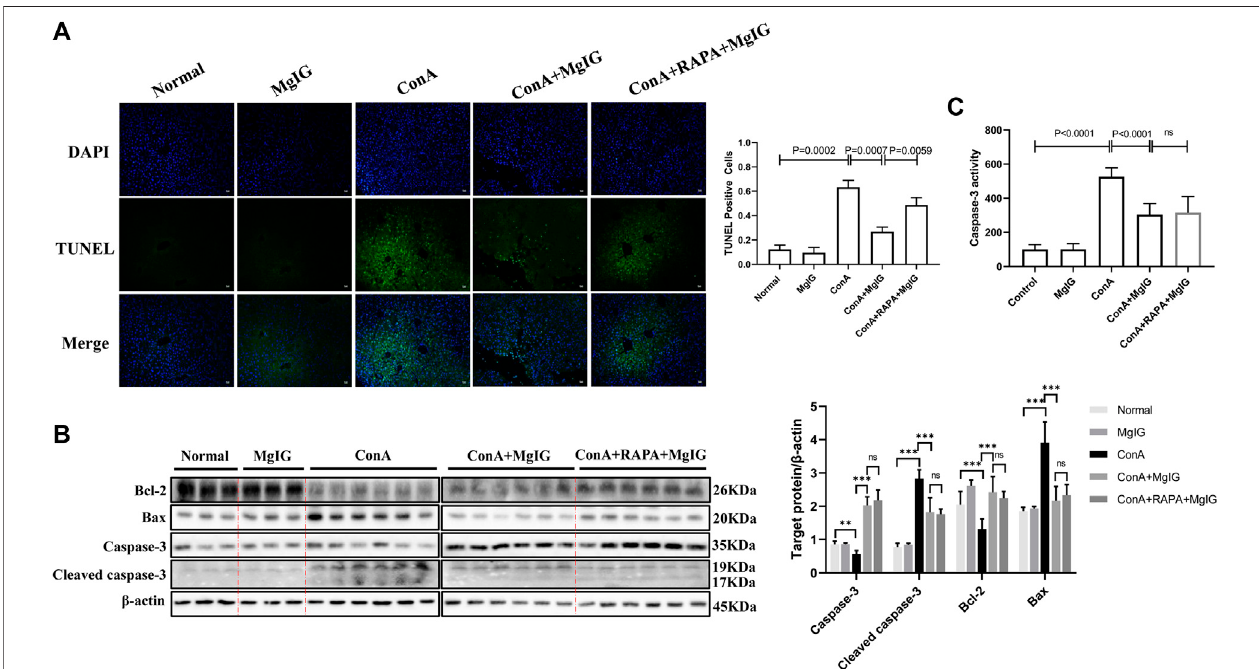
FIGURE 4 | MgIG reduces hepatocyte death in liver tissues affected by ConA-induced liver injury. The data are shown as the mean and SD of at least three independent experiments. (A) Representative images of TUNEL-stained frozen liver tissue sections at 100 × magni fi cation. Quanti fi cation of stained cells to evaluate hepatocyte death in liver tissue. (B) Caspase-3, cleaved caspase-3, Bax and Bcl-2 expression levels in liver tissue were measured by western blotting, with β -actin as a control (*** p < 0.001, ** p < 0.01). (C) Analysis of caspase-3 activity levels in liver